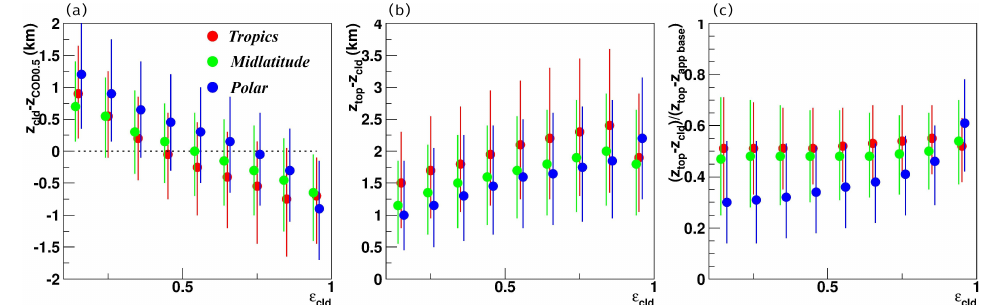
Figure 4. (a) z cld – z COD0 . 5 , (b) z top − z cld and (c) ( z top − z cld ) / ( z top − z app base ) as functions of ε cld for high-level clouds in the tropics, midlatitudes and polar latitudes. Presented are median values and the interquartile ranges. Three years of statistics, for which z cld and z COD0 . 5 lie within vertical cloud borders from GEOPROF. Observations at 01:30LT.